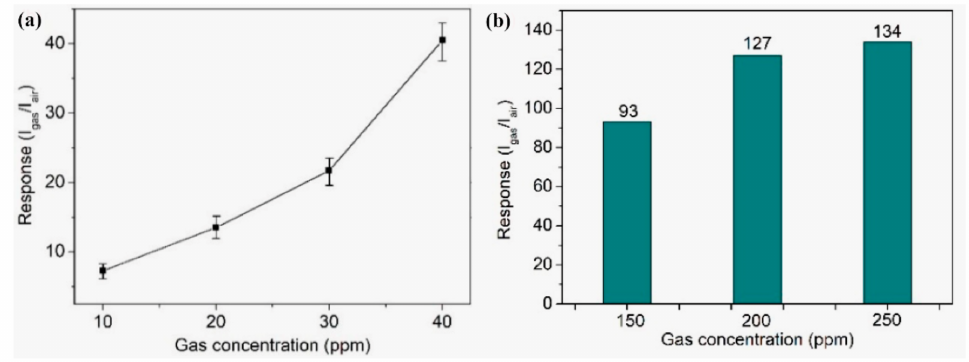
Figure 28. The sensing response of carbonaceous particles/SnO 2 -based gas sensor towards ethanol: ( a ) at concentrations 10, 20, 30, and 40; ( b ) response toward 150, 200, and 250 ppm of ethanol. Reprinted from Ref.